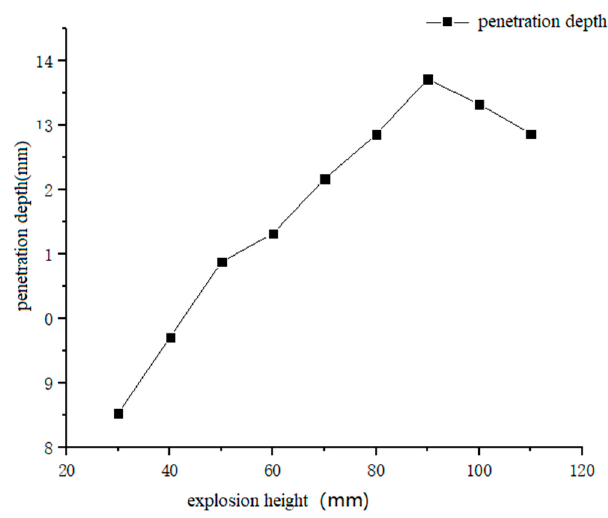
Figure 10. Curves of penetration depth that correspond to different explosion heights.